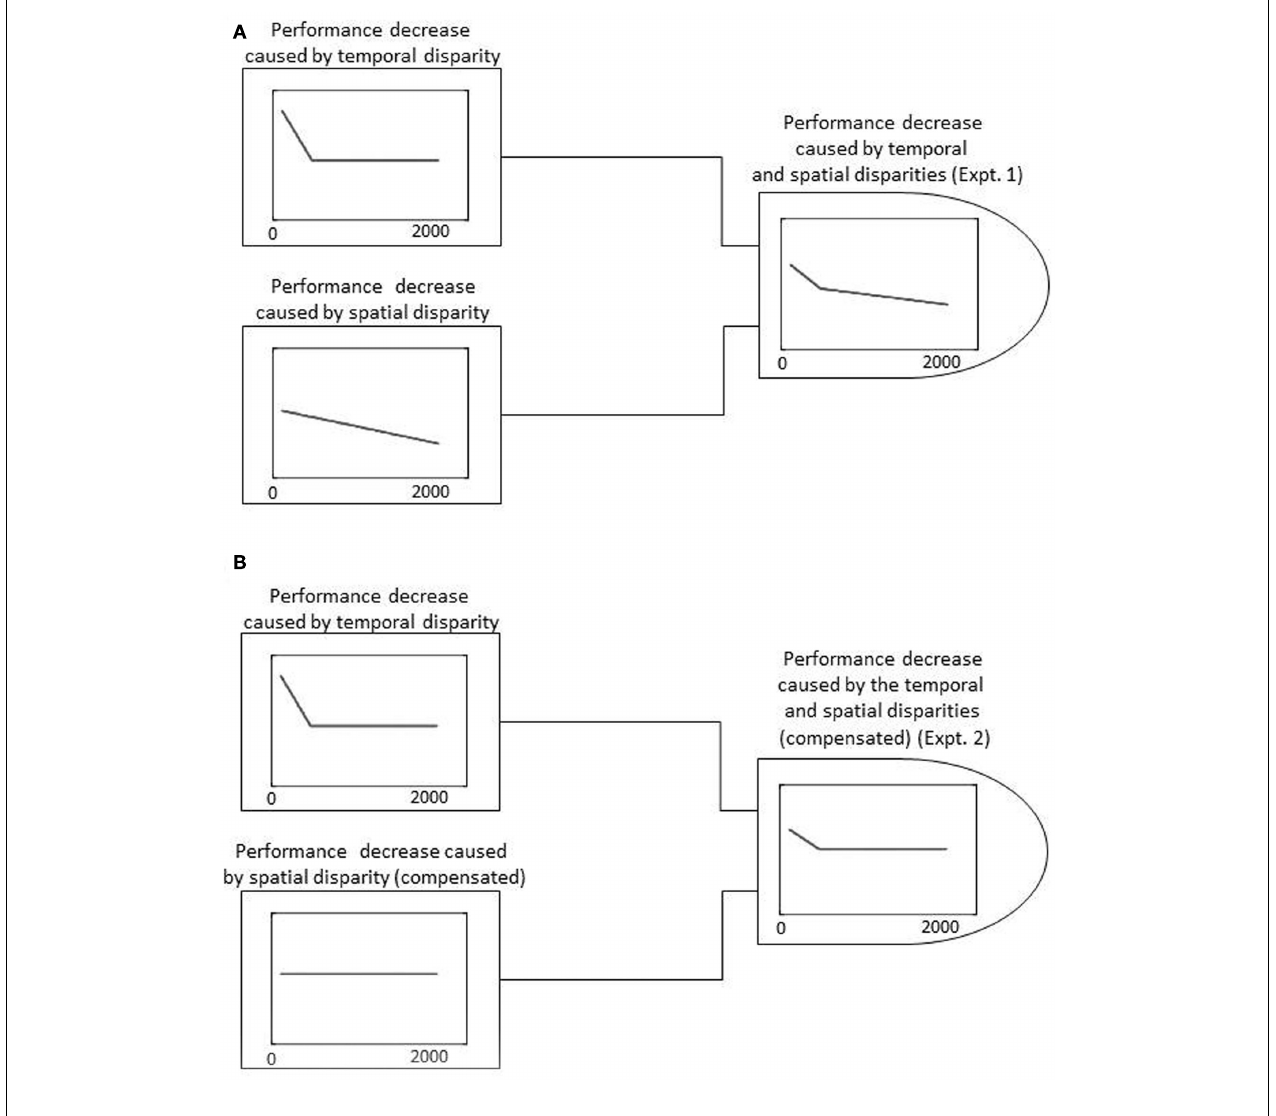
right. (B) Possible model for delayed visual feedback under the experiment 2 condition.The performance decrease caused by the temporal and spatial disparities (compensated by a haptic source) are shown separately on the left, while the weighted summation of the two is shown on the